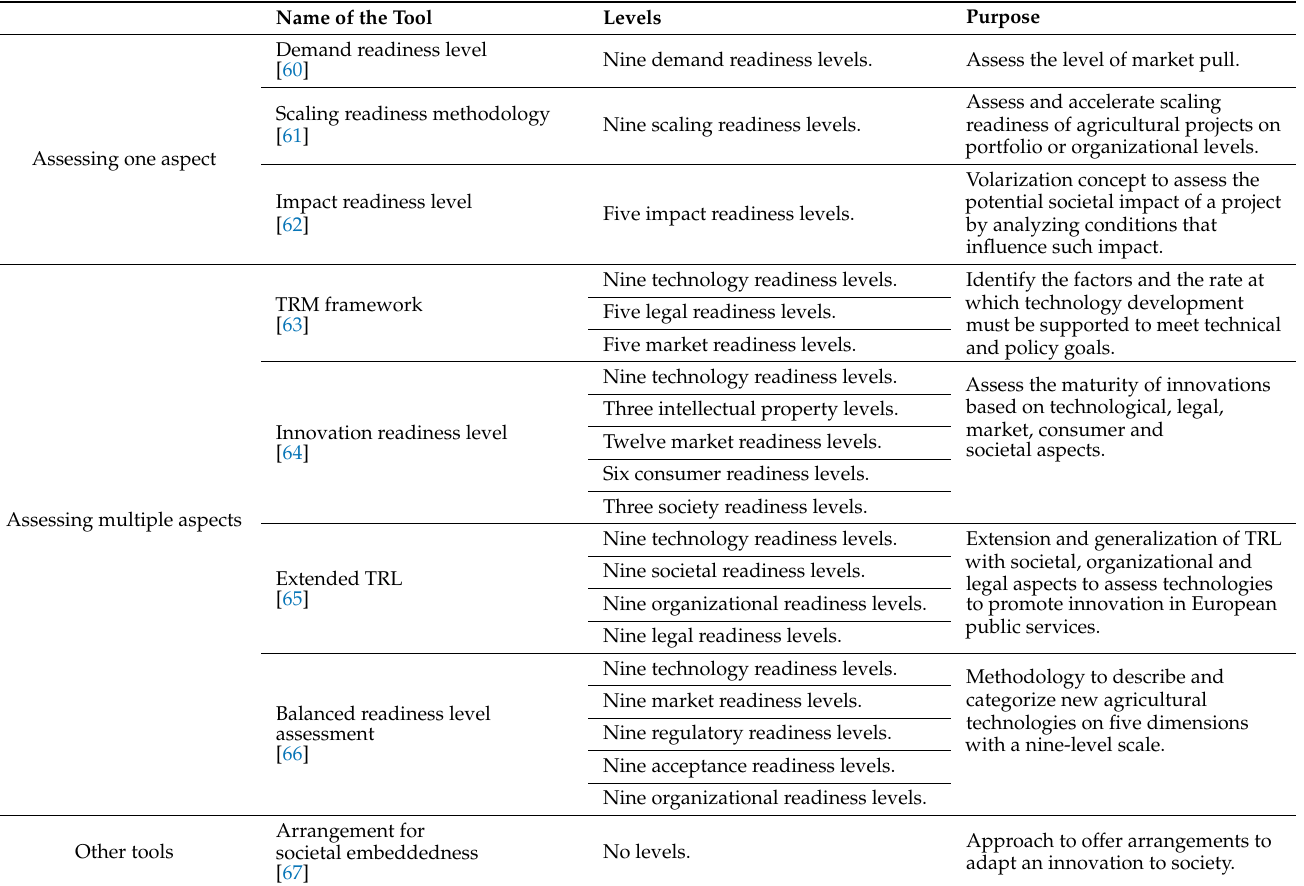
Table 2. Readiness level